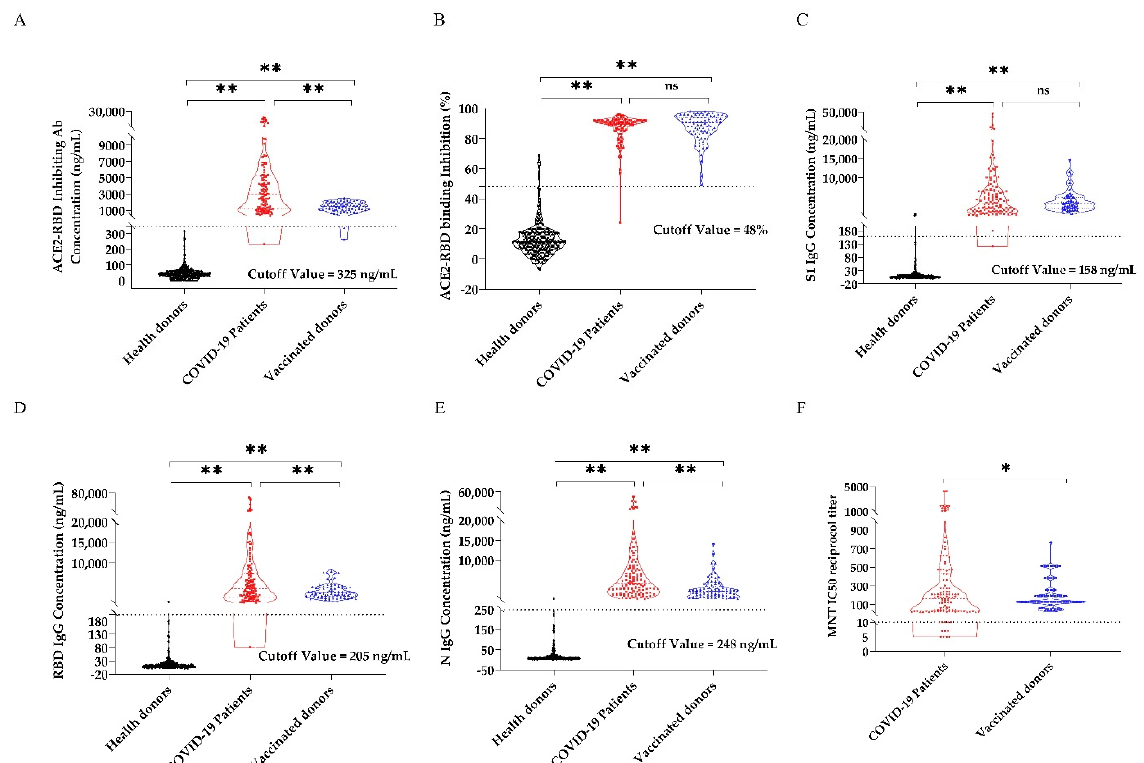
Figure 2. ACE2-RBD-inhibiting antibody, SARS-CoV-2 specific IgG and microneutralization test results of 119 convales- cent samples, 86 vaccinated samples and 299 health control samples. ( A ) ACE2-RBD-inhibiting antibody concentration. ( B ) ACE2-RBD binding inhibtion. ( C ) S1-IgG. ( D ) RBD-IgG. ( E ) N-IgG concentrations. ( F ) Neutralizing antibody titer of 119 convalescent samples, 86 vaccinated samples, and 299 health control samples were measured using CLIA and MNT. The 119 convalescent samples results are shown as red dots, the 86 vaccinated samples results are shown as blue dots, and the 299 health control samples results are shown as black dots. Dashed lines represent the cutoff for positive sample designation, determined by ROC curve. Results between each paired groups were analysis by t test, and means significant differences between two groups were shown as ** ( p < 0.01) and * ( p < 0.05). No significant difference was shown as ns, p > 0.05.